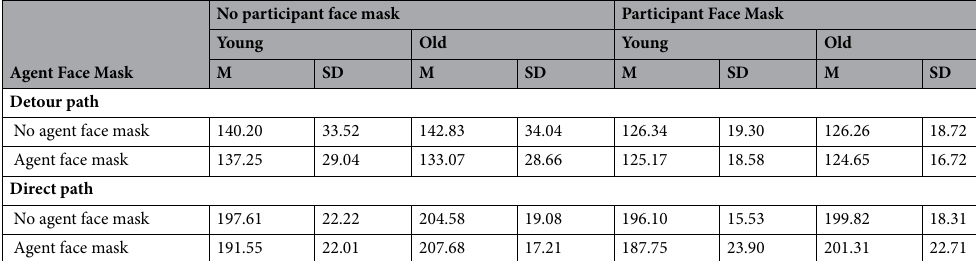
Table 1. Mean (M) and standard deviation (SD) of the minimal distance kept towards virtual agents in cm. Data is shown for all conditions depending on the factors Face Mask participant (no mask vs. mask), Face Mask Agent (no mask vs. mask), Agent Age (young vs. old), Trialtype (detour path vs direct path).